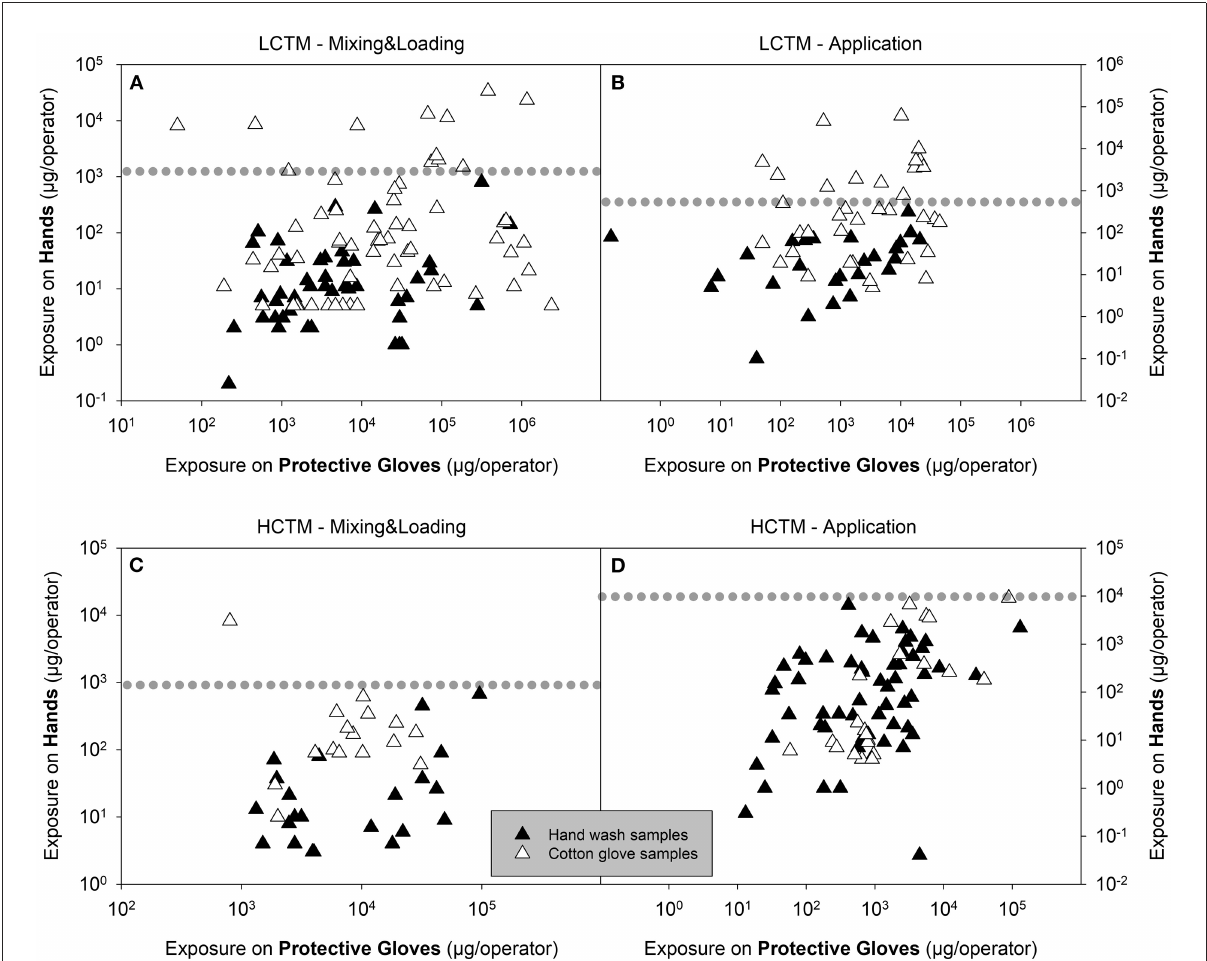
FIGURE1 Exposure on hand plotted against exposure on cotton gloves for LCTM (A,B) and HCTM (C,D) during mixing and loading [M&L, (A,C) ] or application (B,D) of liquid formulation. Black and white triangles represent hand wash samples and cotton glove samples, respectively. The dotted line indicates the level of the highest hand wash sample. Values above the dotted line are from cotton glove samples